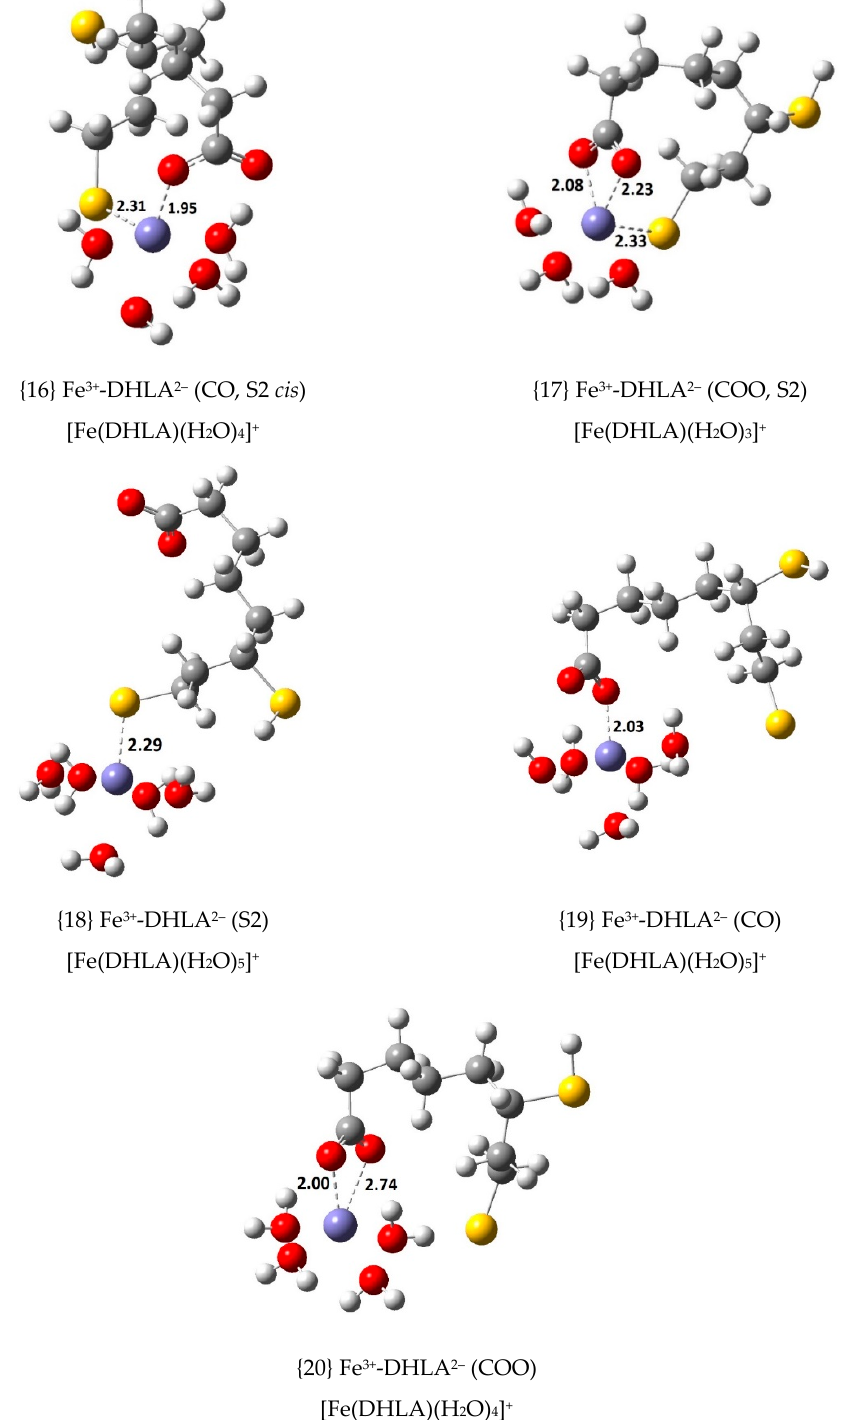
Figure 5. Optimized geometries of the 1:1 complexes of Fe(III) with S2-deprotonated DHLA 2 − (bond distances in Å).